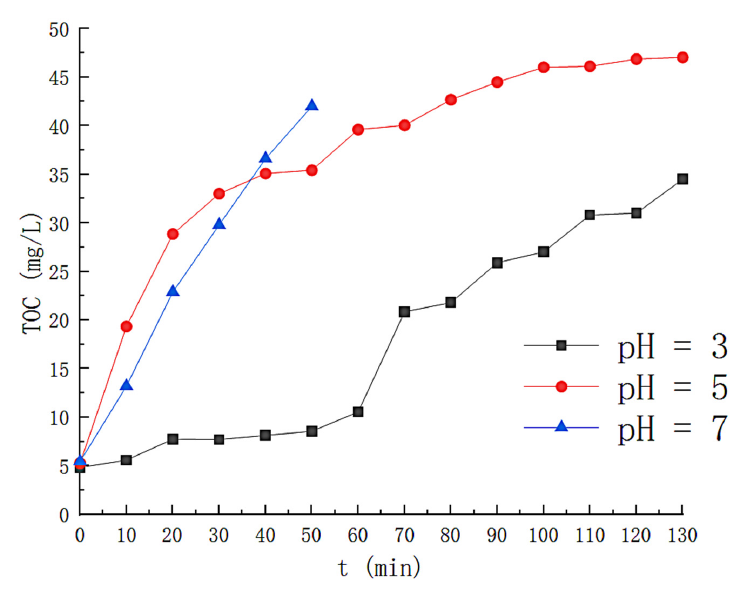
Figure 5. Effect of different pH on TOC concentration.